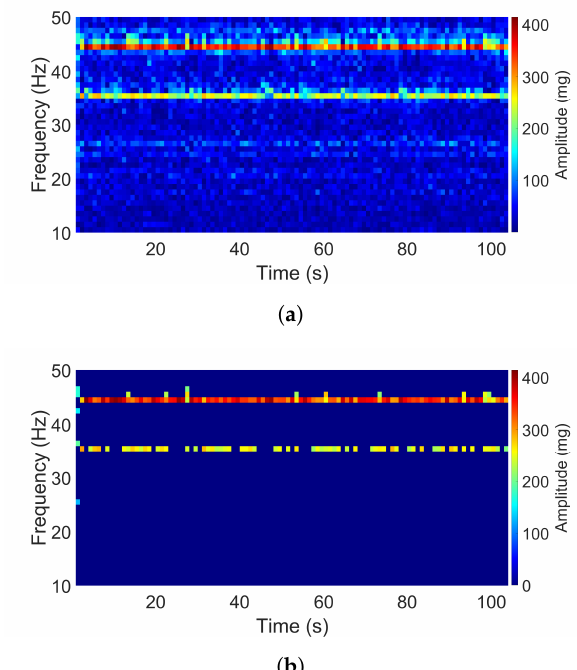
Figure 8. Spectrogram of the air-pump signal (Z direction): ( a ) Original. ( b ) Filtered.